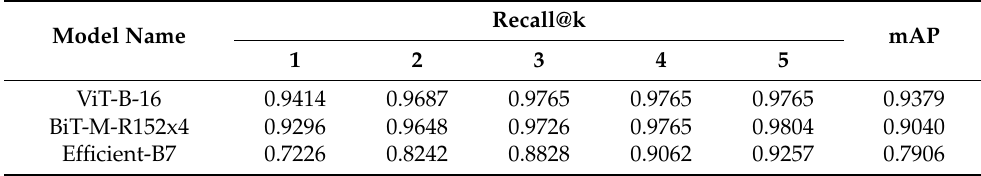
Table 3. Recall@k and mAP comparison between different encoding